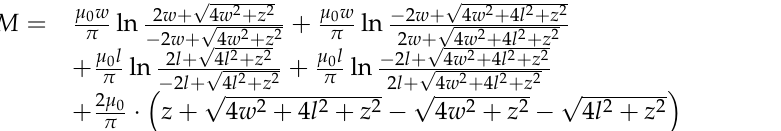
According to the design requirements, substituting w = 200 mm and l = 300 mm into formula (3) can acquire the relationship between the mutual inductance and the distance between the coils when the single-turn coil is aligned, as shown in Figure